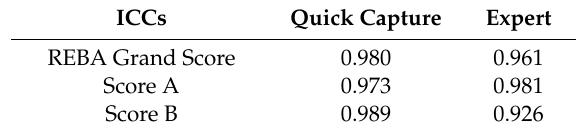
Table 4. ICC results of experts and Quick Capture.